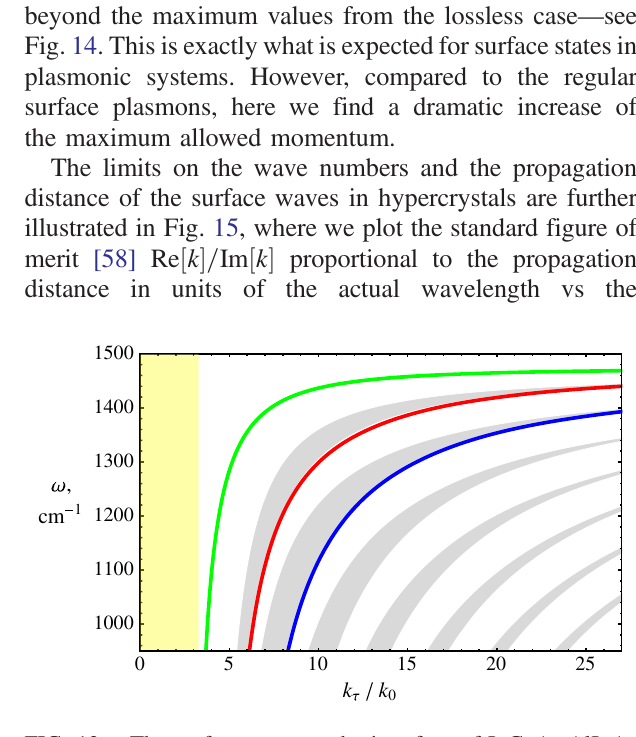
FIG. 13. The surface states at the interface of InGaAs:AlInAs semiconductor-based hypercrystal and dielectric (Al 0 In 0 As), . 48 . 52 in the lossless limit. Gray areas correspond to the volume- propagating bands of the hypercrystal. The color code represents surface states of zero (green), one (red), and two (blue) orders. The unit cell of the hypercrystal is formed by 1 . 9 - μ m-thick semiconductor hyperbolic metamaterial, and a 100-nm-wide layer of n þ -doped In 0 Ga 0 As (with a plasma wavelength . 53 . 47 of 5 μ m). The yellow band marks the light cone of the dielectric covering the